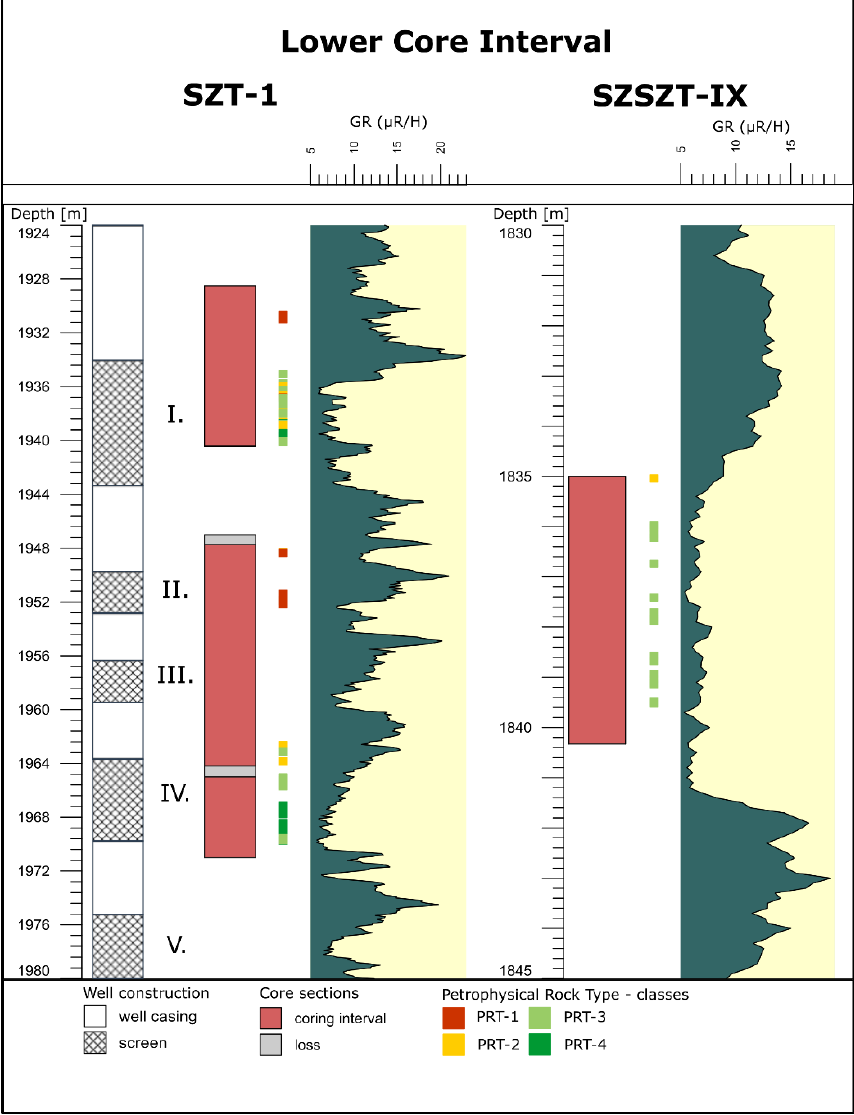
Figure 15. Comparison of screen intervals (I to V), core sections, gamma ray (GR) logs, as well as Petrophysical Rock Typing (PRT) classes of wells SZT-1 and SZSZT-IX.